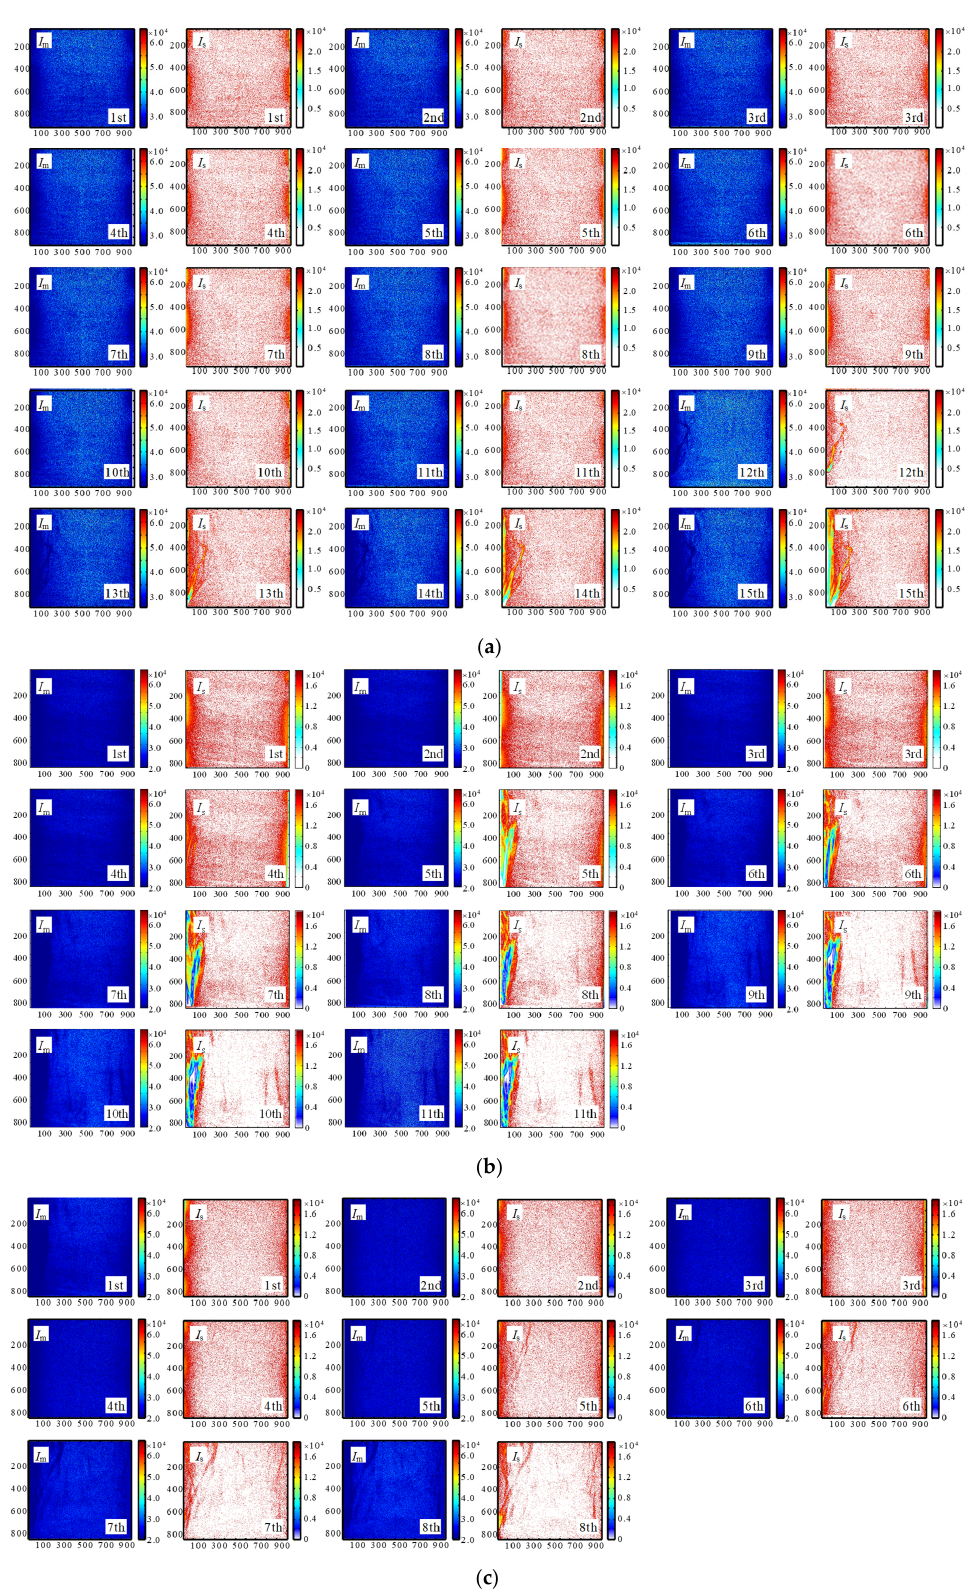
Figure 7. Image segmentation of red-bed mudstone matrix and damaged seepage features and interpretation on X-ray absorbed dose data. ( a ) RBM-01 specimens; ( b ) RBM-02 specimens; ( c ) RBM- 03 specimens. Table 3. Statistical Results of the Multilevel Stress Peak and Hydro-Damage Coefficient During Red- Bed Mudstone Specimen Failure.